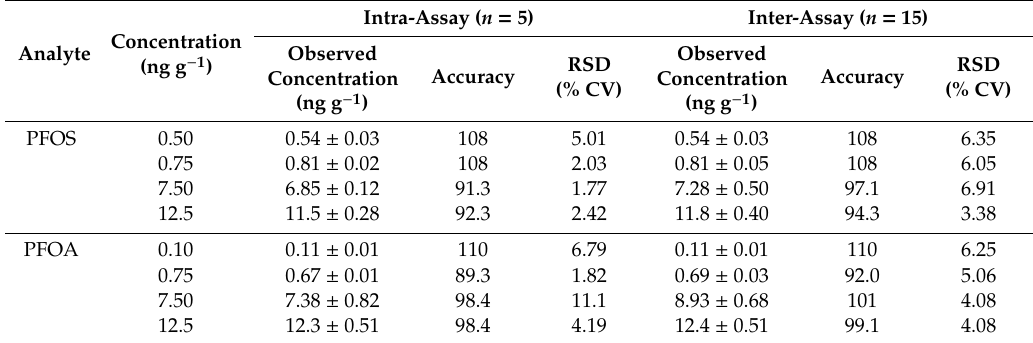
Table 1. Intra- and inter-day accuracy and precision for PFOS and PFOA (mean ± SD).